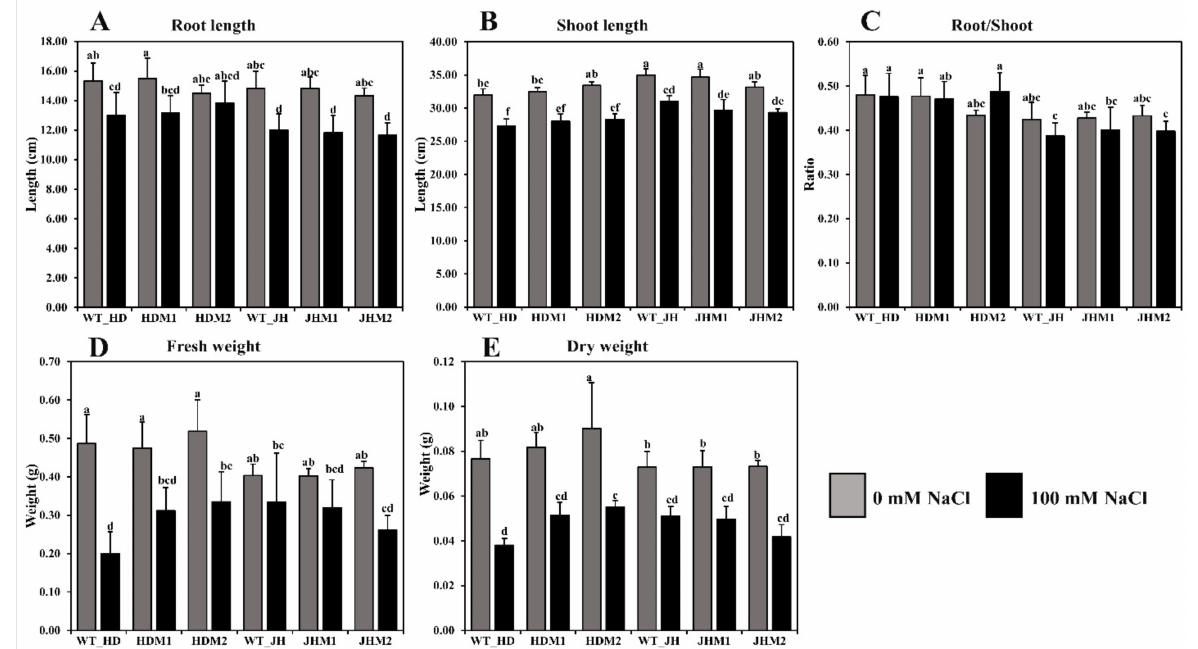
Figure 3. Differences in the morphophysiological parameters under salinity stress: ( A ) root length (cm); ( B ) shoot length (cm); ( C ) root-to-shoot ratio; ( D ) fresh weight (g); ( E ) dry weight (g). Grouping information was obtained using the Tukey method at a 95% confidence level. Means that do not share the same letter are significantly different at a 5%